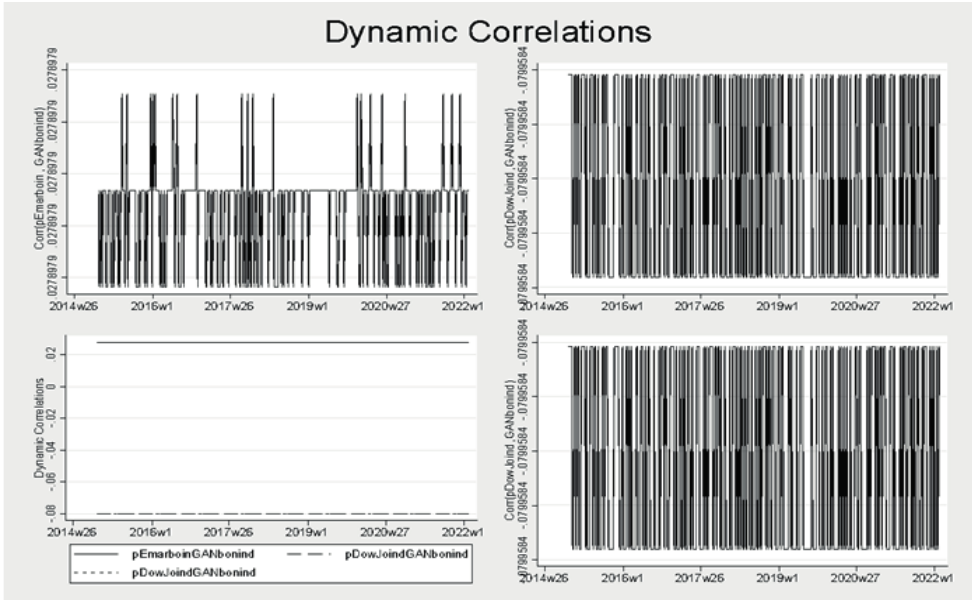
Fig. 2. CCC between the exogenous variables and sovereign bond return of